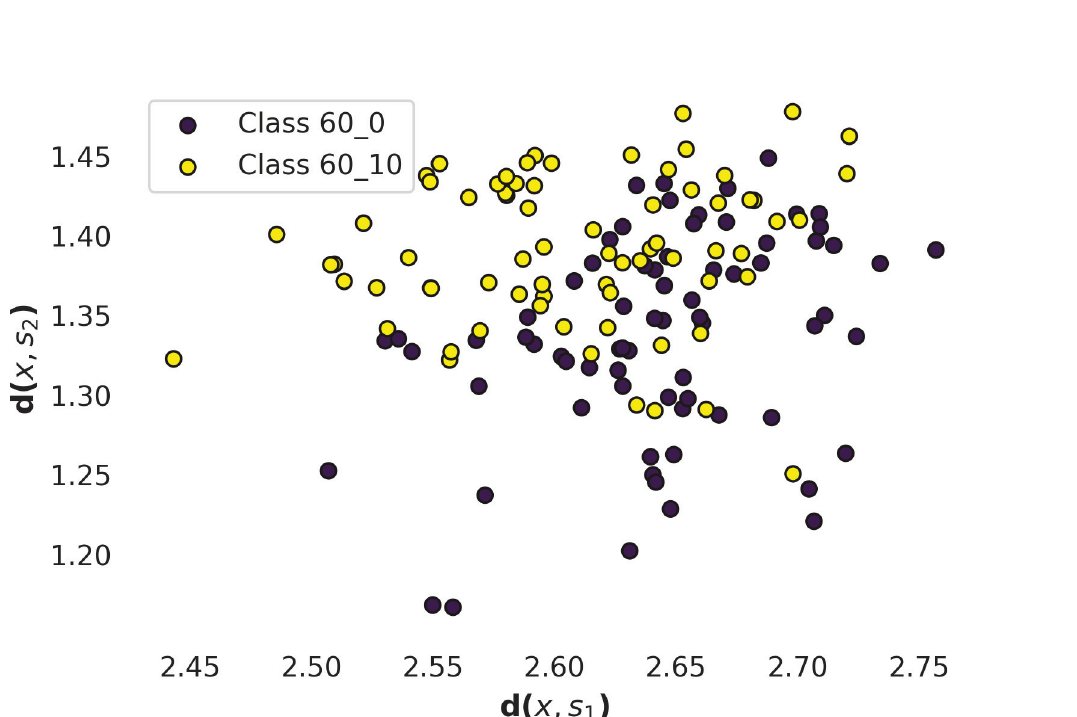
Fig 5. The shapelet–transform representation of the input data describing mitoBK activity obtained at naringenin concentration of [Nar] = 0 μM (purple dots) and [Nar] = 10 μ M (yellow dots) and the same membrane potential U m = 60 mV. Graph represents the distances d ( x , s 1 ) and d ( x , s 2 ) of all dwell time samples included in the dataset to two representative shapelets presented in Fig 3 calculated according to Eq